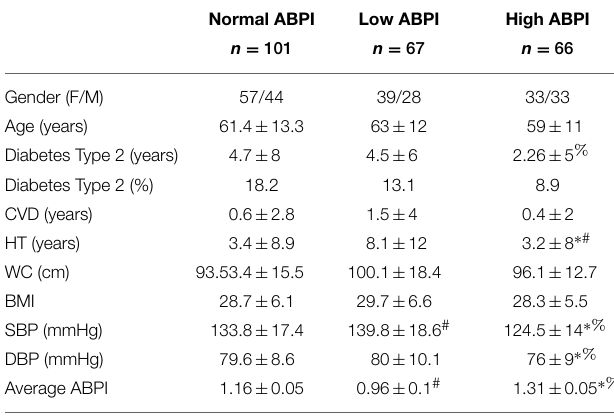
TABLE 1 | Physiological differences in the cohort between those with normal, low and high ABPI. Normal